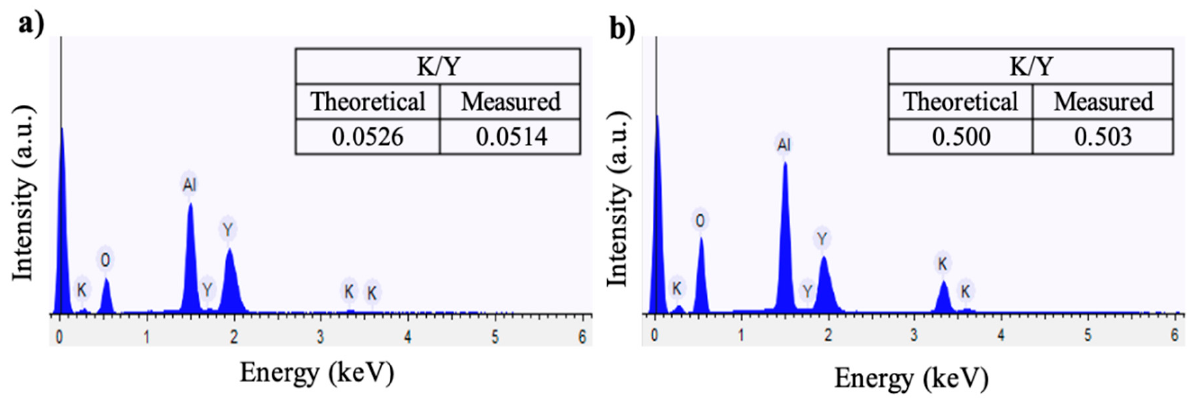
Figure 5. EDX analysis spectra of Y 2.85 K 0.15 Al 5 O 12 ( a ) and Y 2 K 1 Al 5 O 12 ( b ) samples.